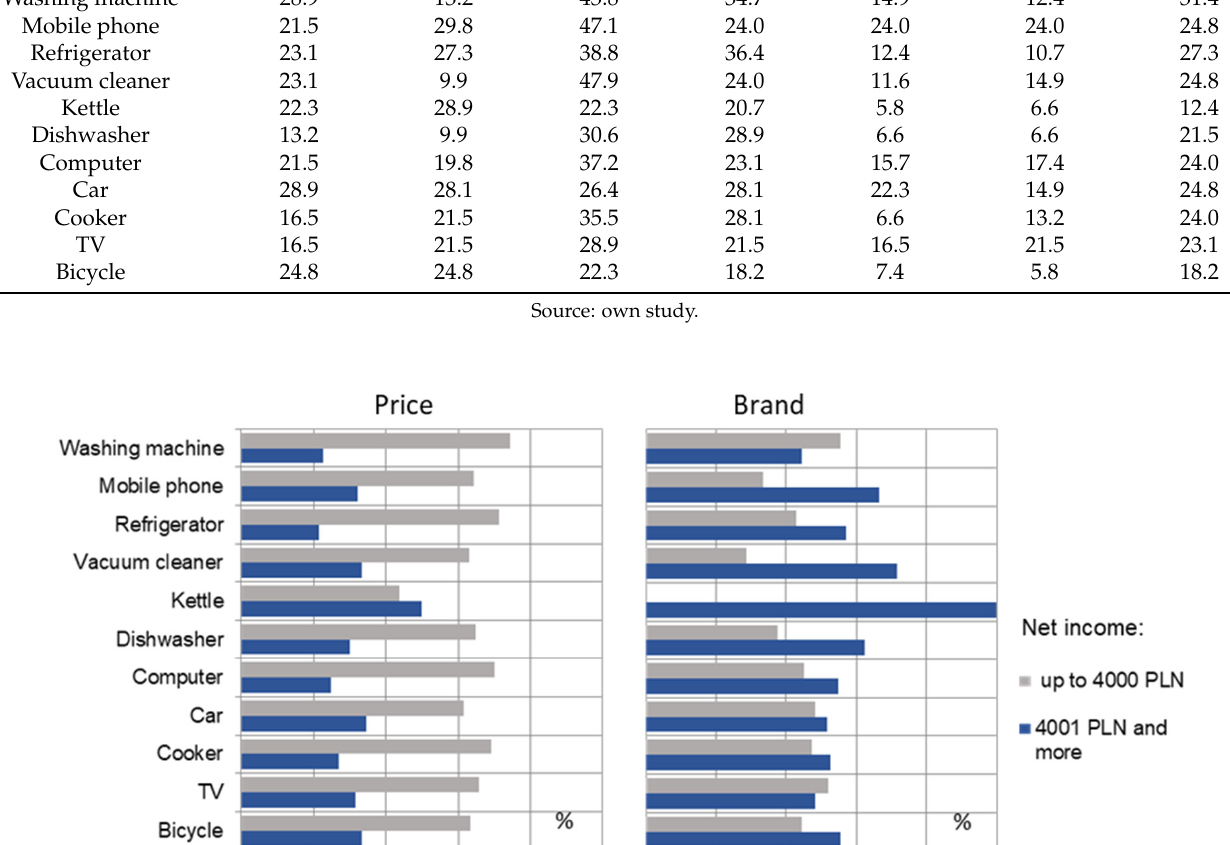
Table 3. Opinions of respondents on the deliberate aging of products depending on the expected life of the equipment used.